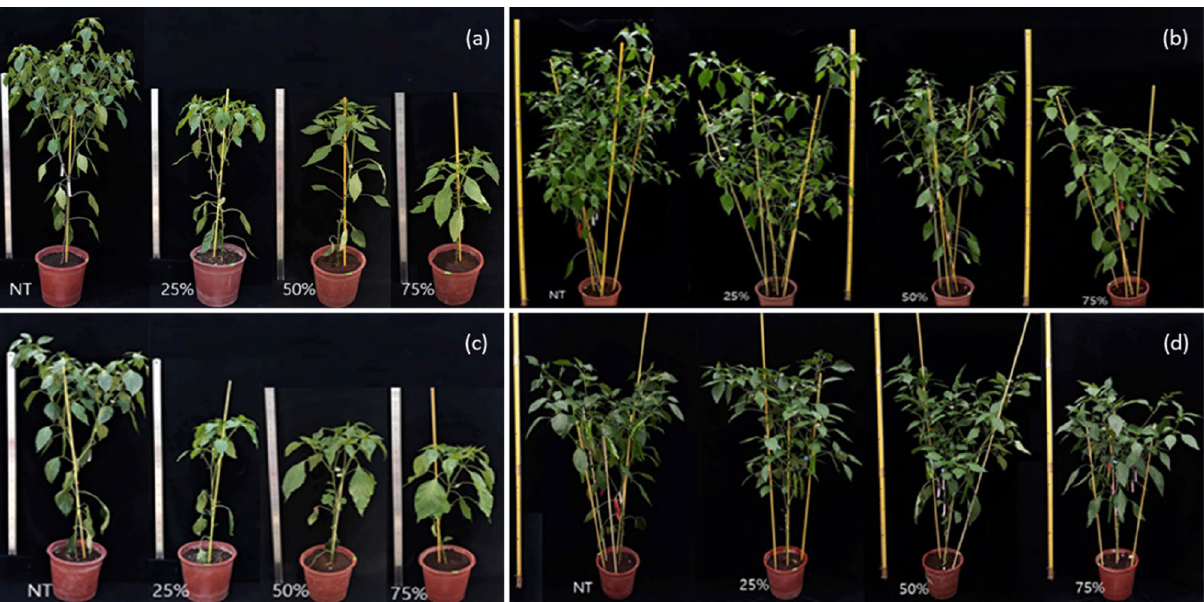
Figure 6. Effect of different leaf heat damages on the recovery of hot pepper plants. Cultivars ‘Chyung Yang’ in 30 days ( a ) and 55 days ( b ), and ‘NW Bigarim’ in 30 days ( c ) and 55 days ( d ) after heat treatment in 42